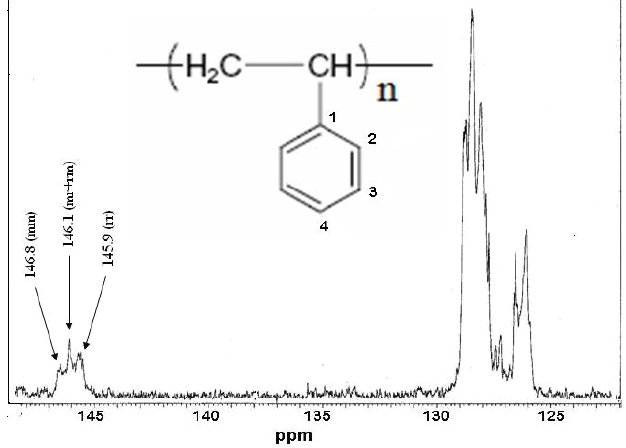
Figure 2. 100 MHz 13 C-NMR spectrum in CDCl catalyst.